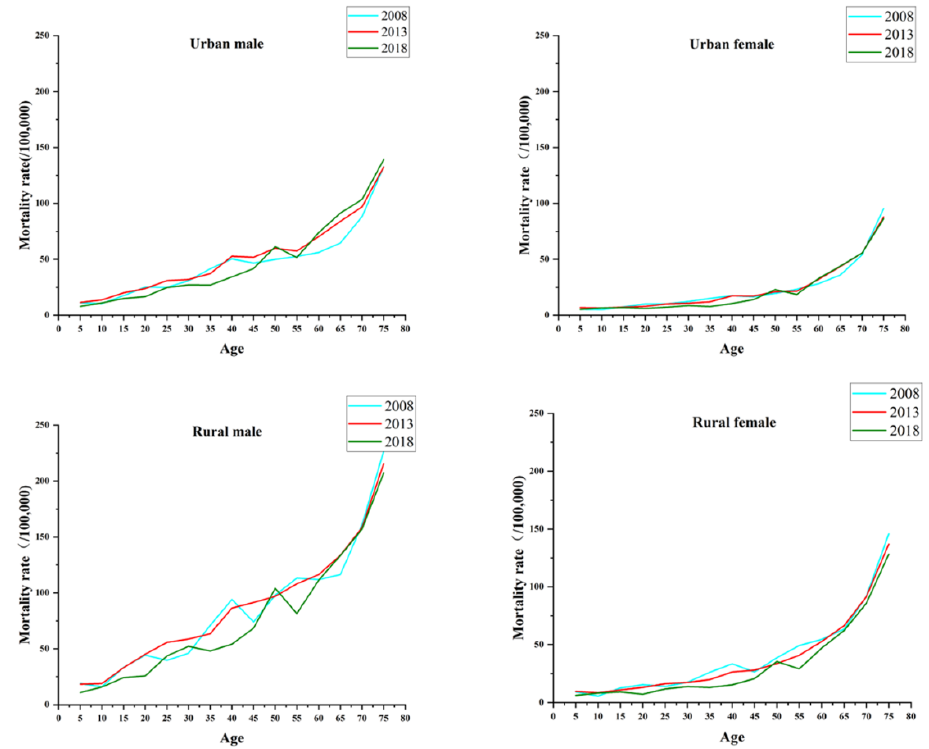
Figure 1. The trends of injury and poisoning mortality in China by gender and region with age.